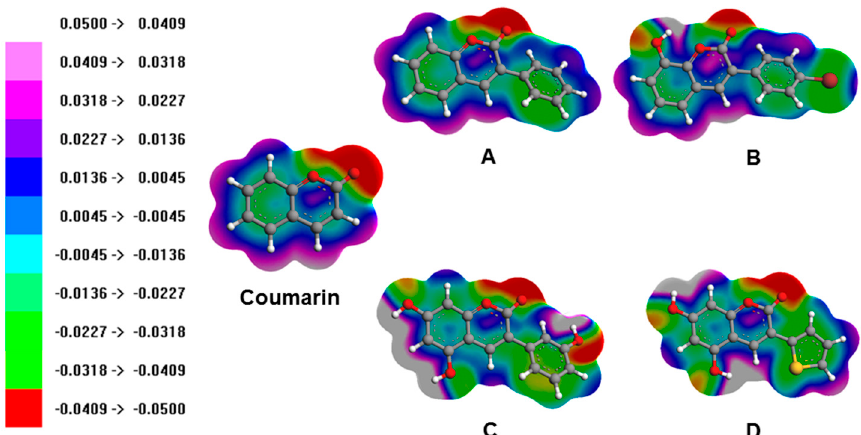
Figure 5. Electrostatic potentials mapped on electron density isosurfaces for coumarin and molecules A – D calculated by DFT (contour plot 0.002). The colors are mapped in accordance with the EP at the point on the isosurfaces.